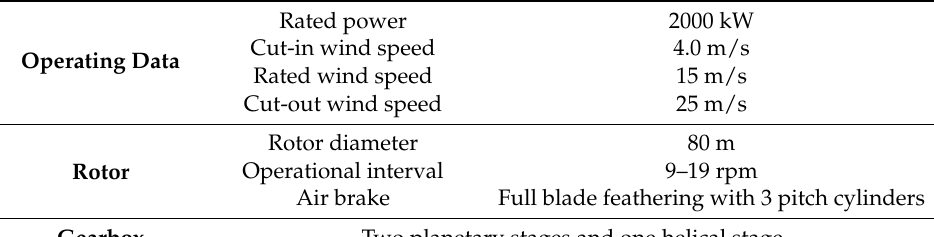
Figure 1. The architecture of the long cycle maintenance time prediction. Table 1. Specification of the V80 module wind turbine.